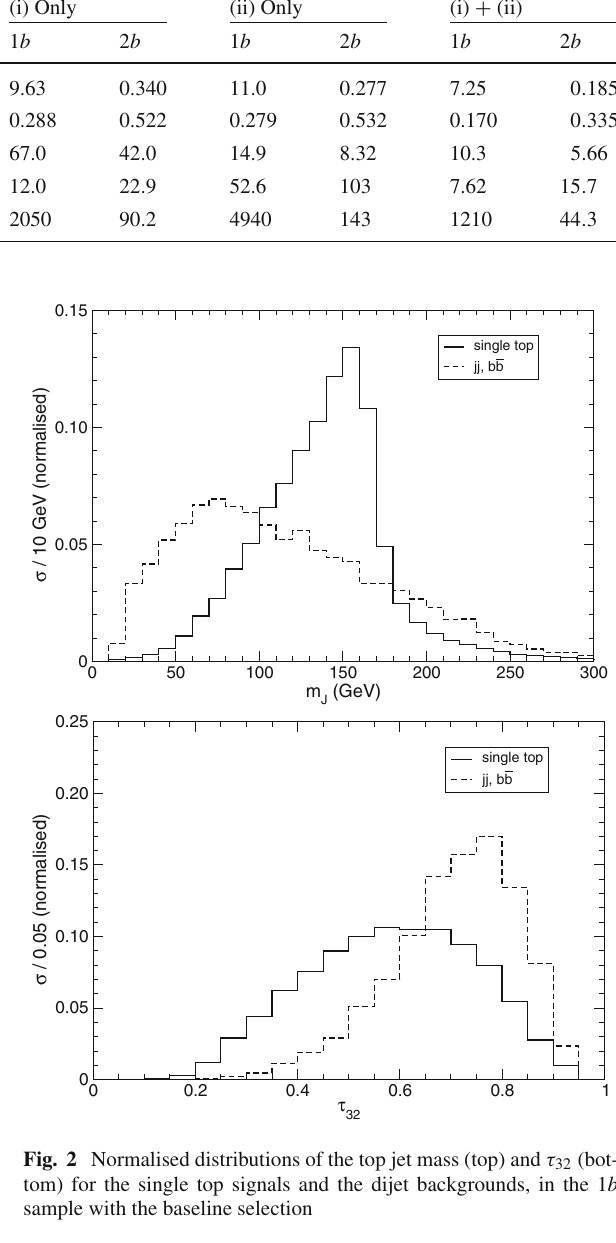
vals and with the same Monte Carlo statistics. Because the kinematics in the high- p T range is similar at 14 and 27 TeV, the main difference being the cross section increase at 27 TeV, we keep the same event selection for simplicity. The cross sections for the different processes with the baseline selection, after the separate sets of cuts (i) and (ii), and after the final selection, are collected in Table 2. The luminosity assumed is L = 15 ab − 1